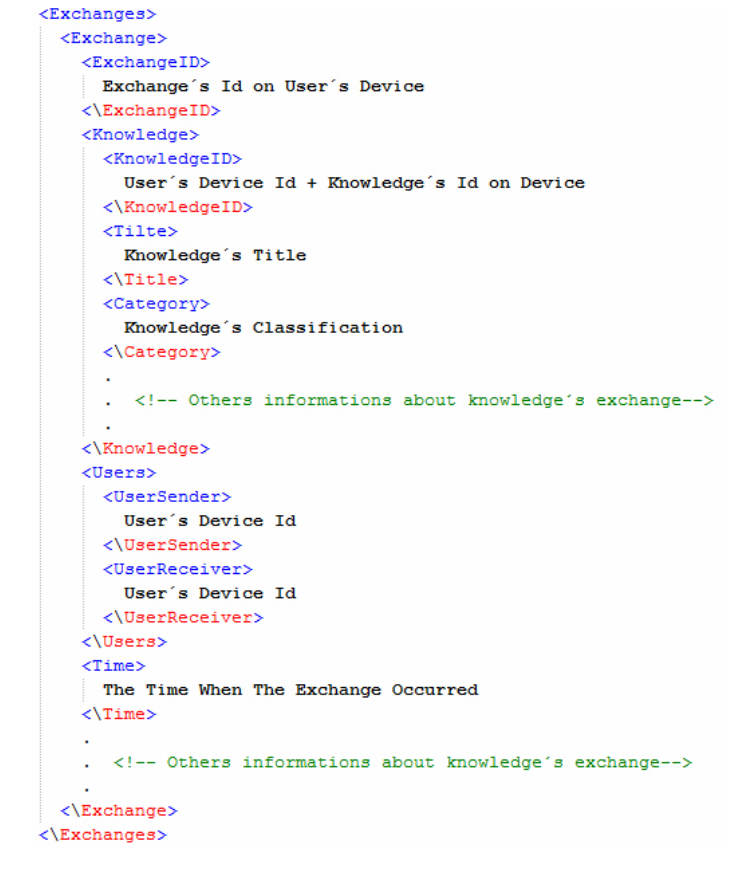
Figure 8. XML structure of the context